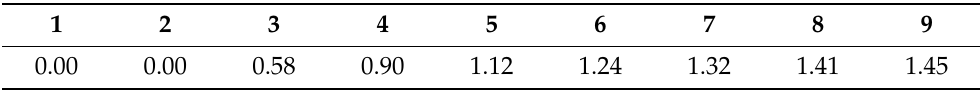
Table 5. RI value of comparison matrix of order